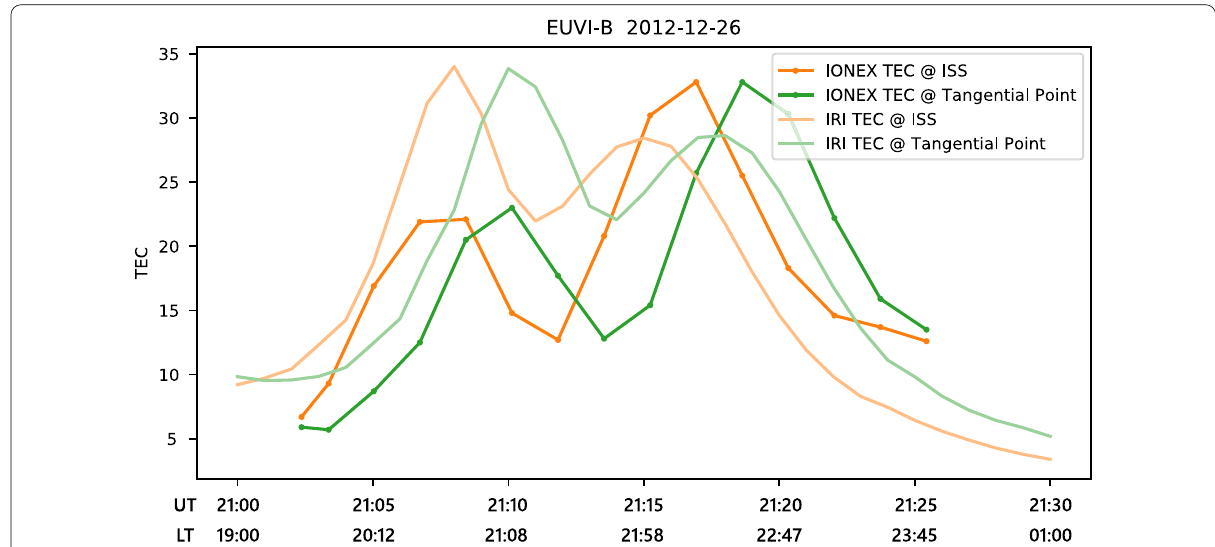
Fig. 7 Comparison of the IONEX TEC values shown in Fig. 3 with the TEC values reconstructed from the IRI model. The IONEX TEC values at the ISS location and the tangential point along the line of sight are plotted with the thick orange and green lines, respectively. The IRI TEC values at the ISS location and the tangential point are plotted with the pale orange and green lines, respectively